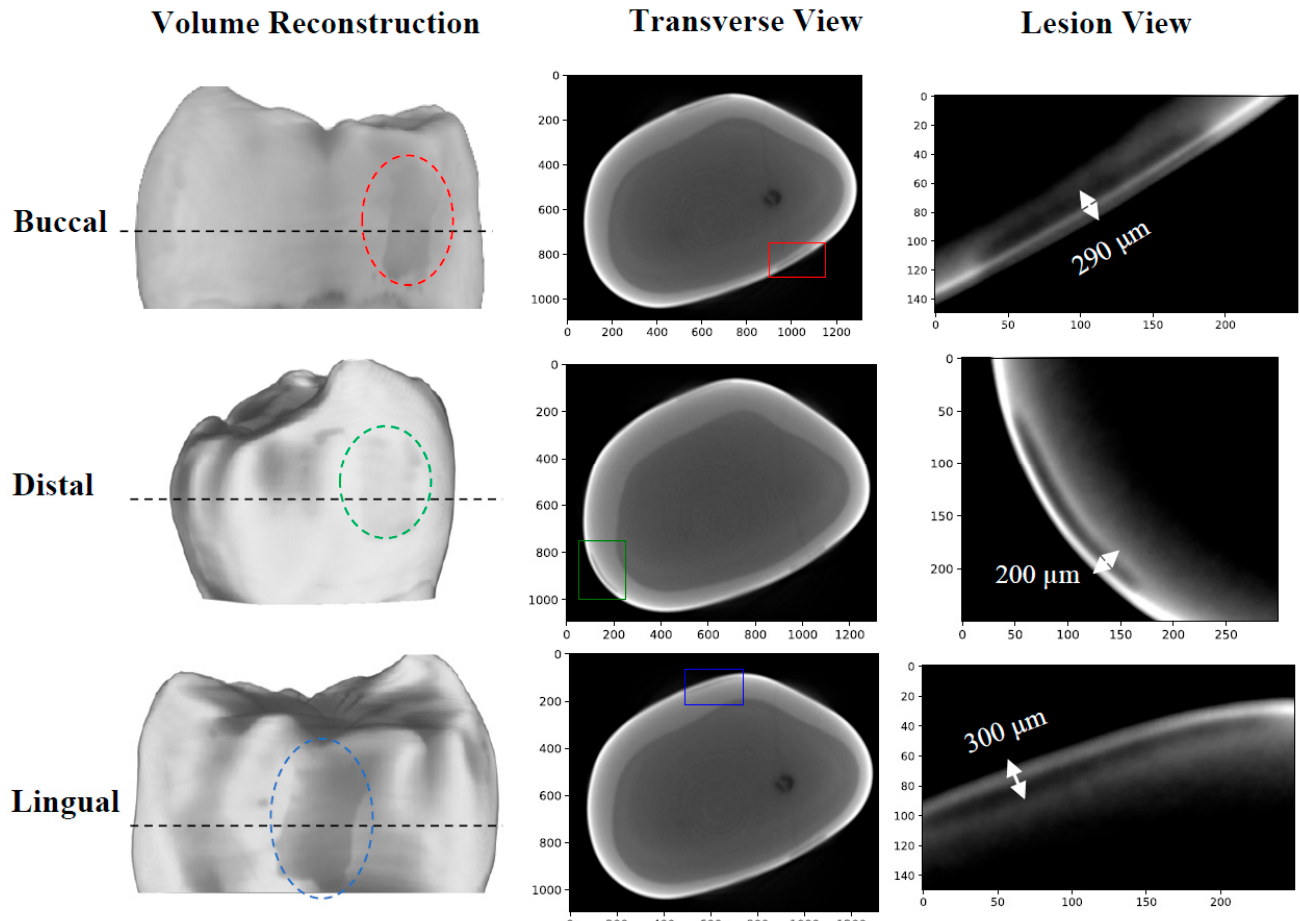
Figure 3. μ -CT images of the B8 sample after 8 days of cariogenic biofilm exposure: Three lesions are visible, one on each of the buccal, distal, and lingual surfaces. The dashed black line corresponds to the cross-sectional plane shown in the transverse views. The colored rectangles on the transverse views outline the position of the lesions. The “Lesion View” column shows an enlarged view of the lesions. To increase the visibility of the lesions, an adaptive histogram equalization was used [30] to improve the image contrast and visualize the edges of the lesion more definitively.